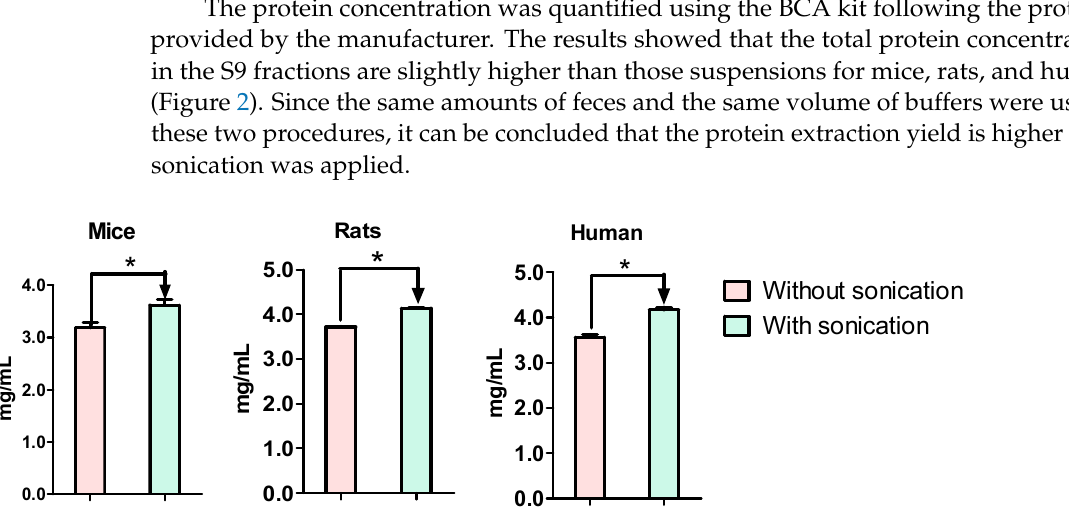
Figure 1. Chemical structures, UV, and a representative UPLC chromatogram of wogonoside and wogonin. Analysis was performed using a Waters Acquity UPLC with photodiode array detector ( A ) a representative chromatogram of wogo- noside, wogonin, and I.S.; ( B ) UV spectrum of wogonoside; ( C ) UV spectrum of wogonin.